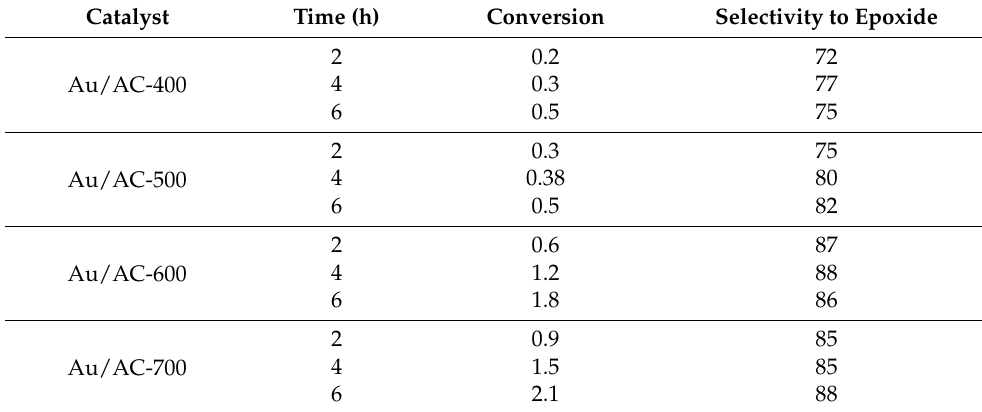
Table 1. Oxidation of cyclooctene using 1% Au/AC catalyst. Catalyst